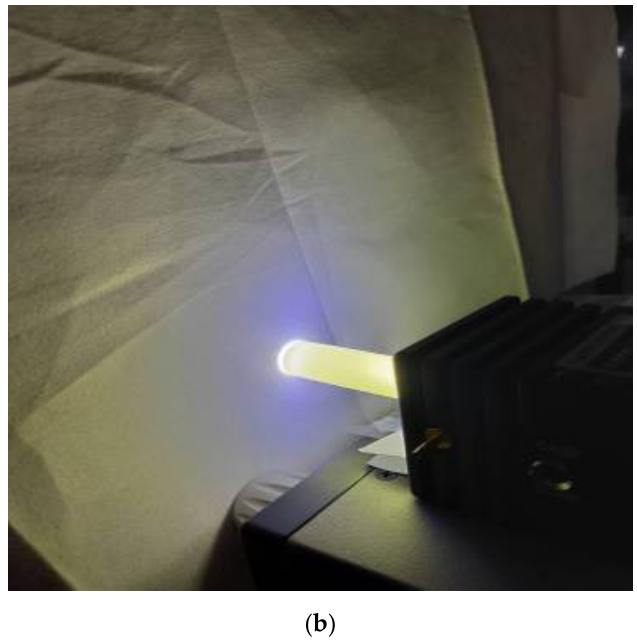
Figure 3. Photographs of ( a ) all the cylindrical rod samples and ( b ) cylindrical rod containing yellow phosphor for laser-driven white lighting in this study.